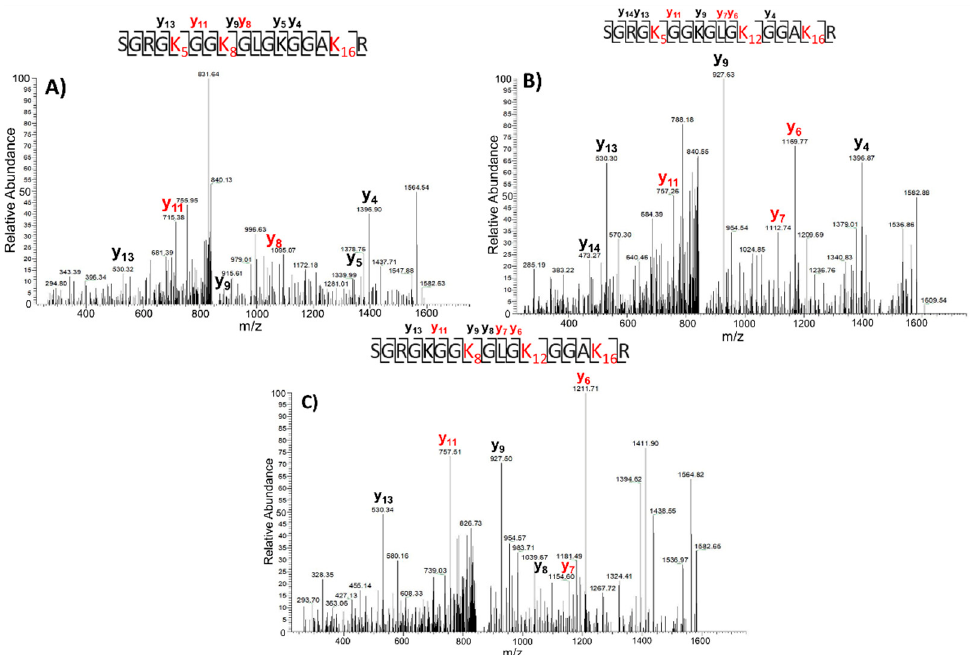
Figure 5. Fragmentation spectra of 1–17 peptide carrying four acetyl groups (including the N-terminus) in TSA-grown cells of ( A ) Peak 1 relative to K5acK8acK16ac (RT: 34.94 min), ( B ) peak 2 relative to K5acK12acK16ac (RT: 35.67 min), and ( C ) peak 3 relative to K8acK12acK16ac (RT: 37.05 min). In red, the differing daughter ions are highlighted.